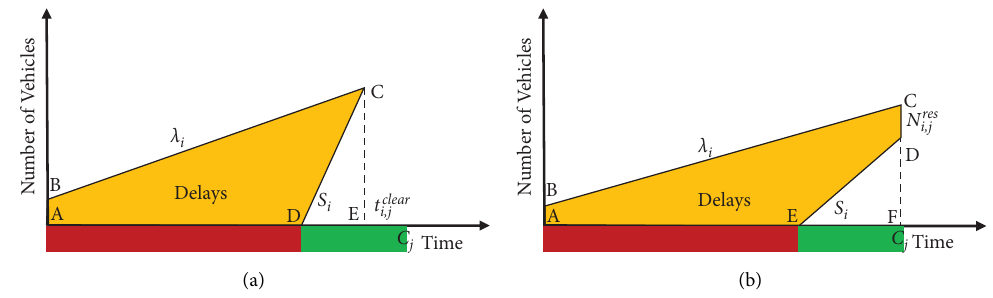
Figure 6: Diagram of state “queue NOT cleared”. (a) End without vehicle left. (b) End with vehicles not